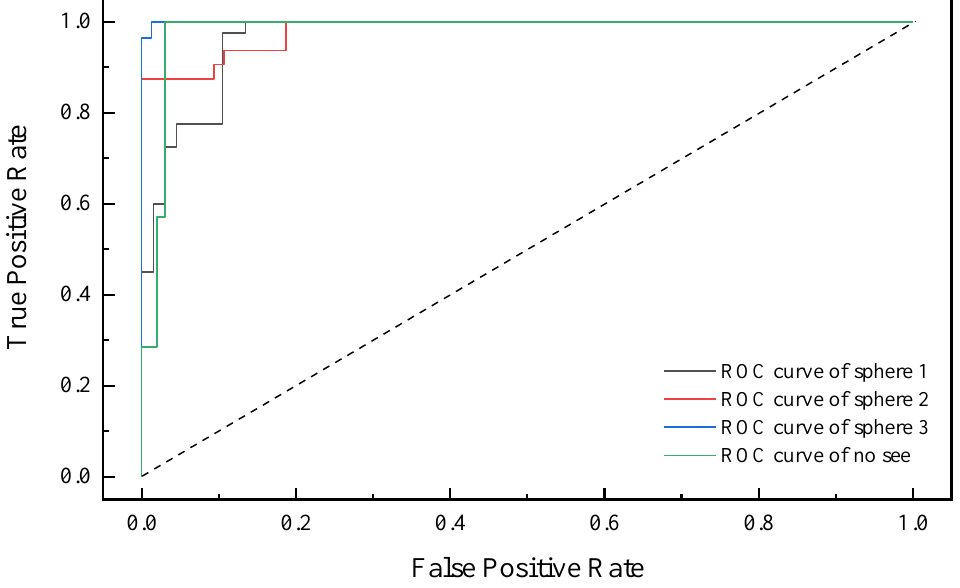
Figure 14. Confusion Matrix.